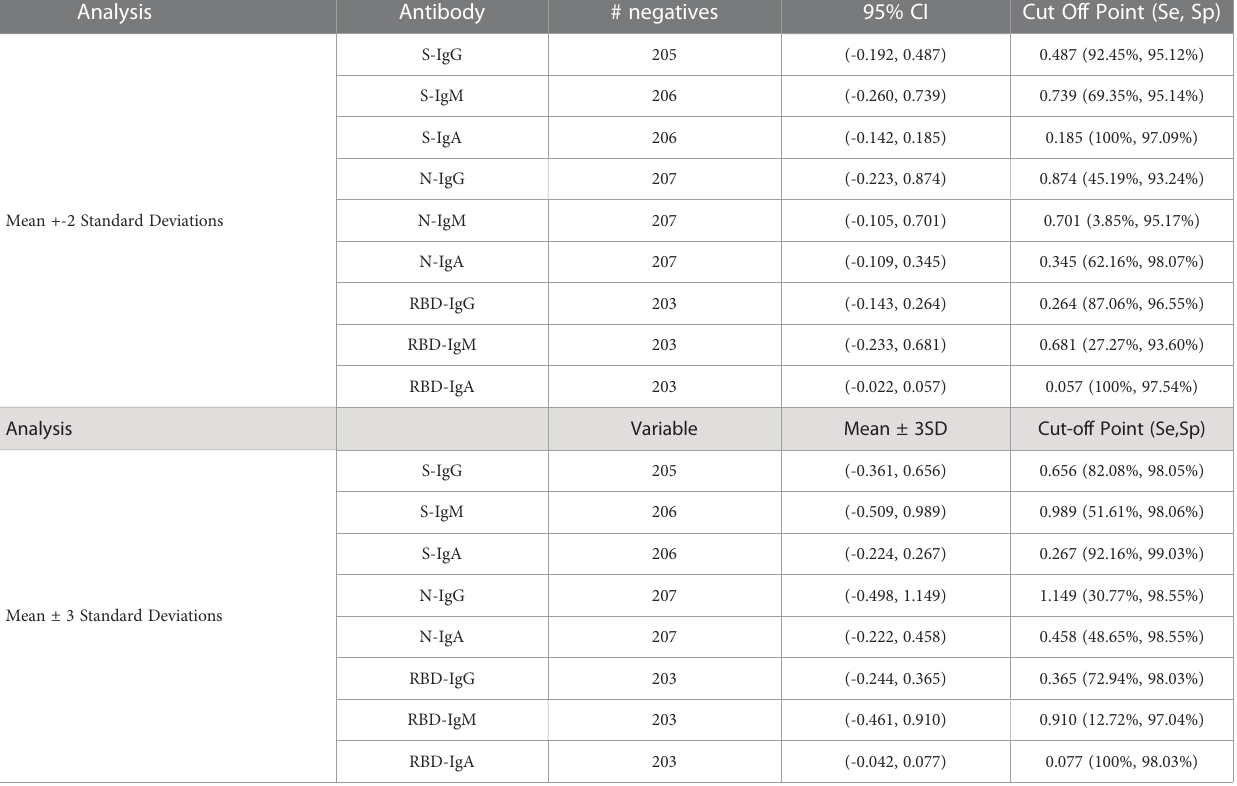
TABLE 4 Computation of Cut-off values using Mean +-2Sd and Mean +-3Sd.